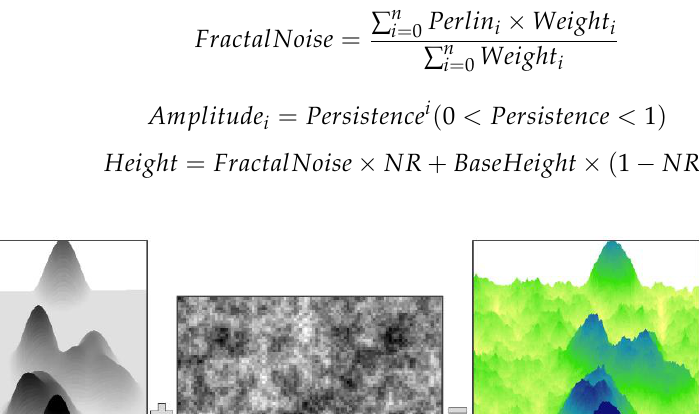
Figure 14. Construction of noisy terrain.